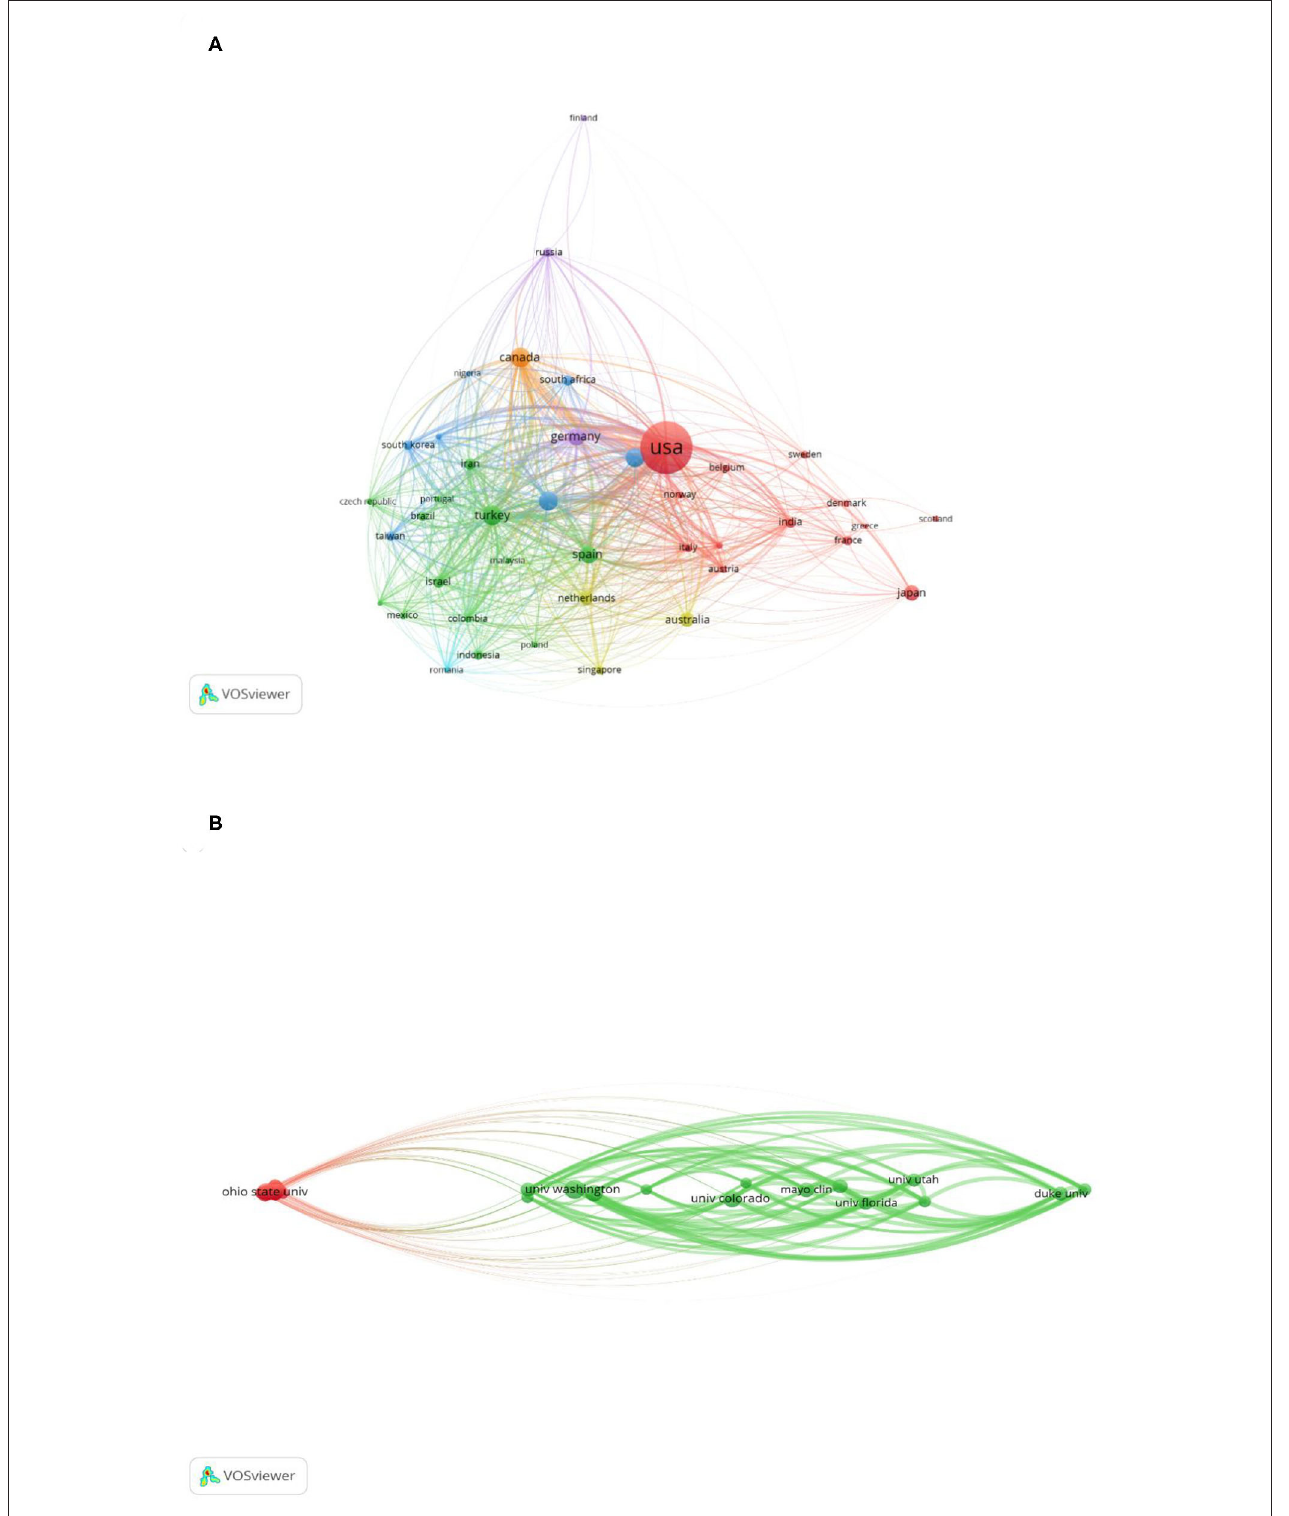
FIGURE 3 | The visualized map of organizations/countries participating in academic procrastination study: (A) Mapping of major countries participating in academic procrastination study. (B) Mapping of organizations involved in academic procrastination study.